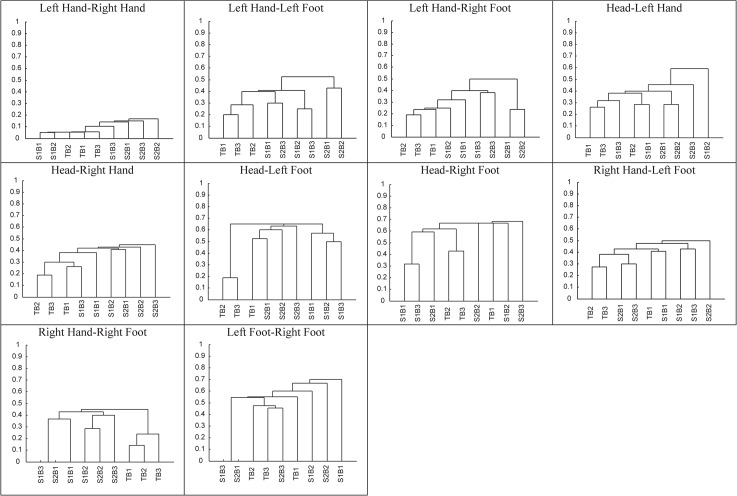
Dendrograms based on Fig 9.